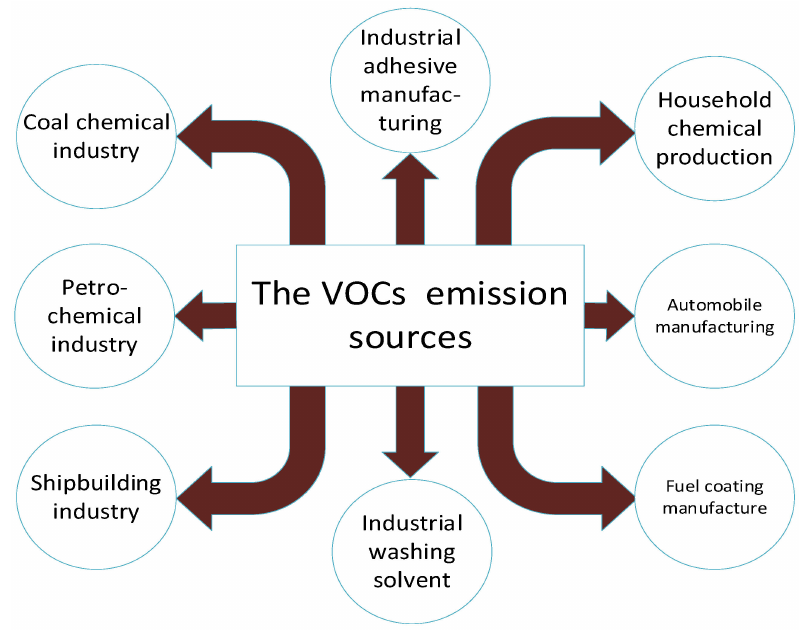
Figure 1. Main sources of the